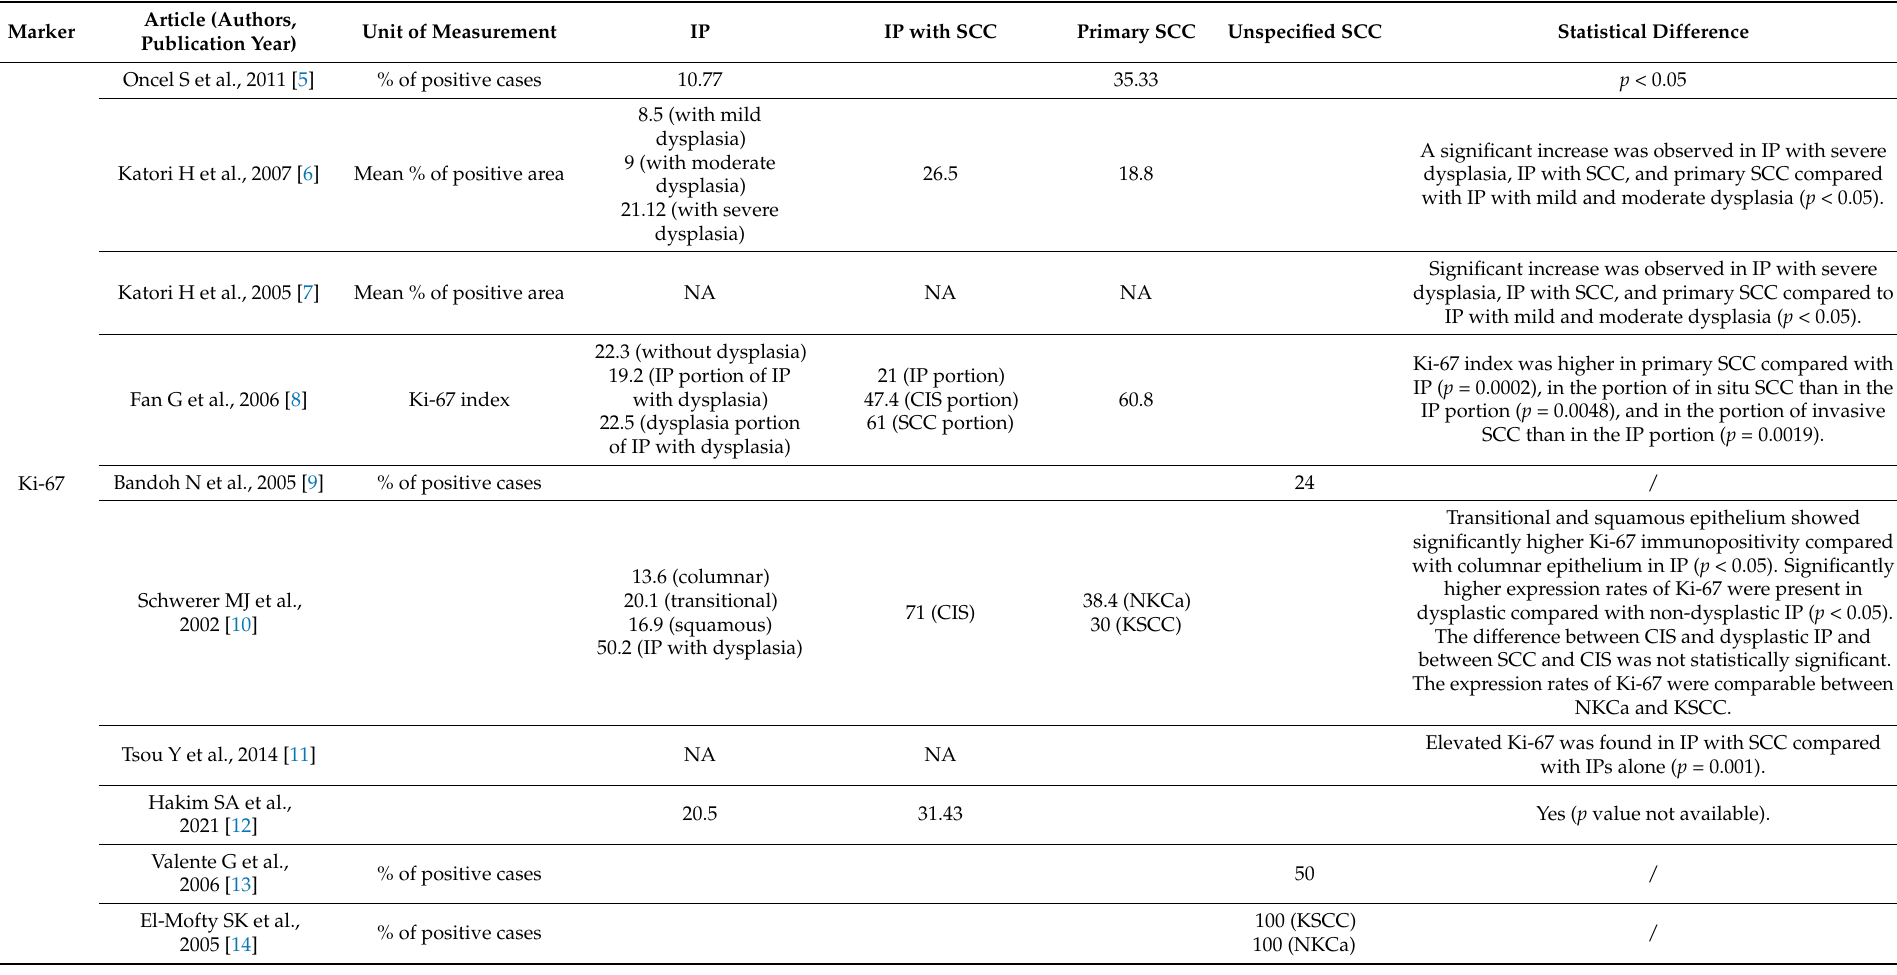
Table 1. Summary of immunohistochemical markers of inverted papilloma (IP) and SNSCC (Sinonasal Squamous Cell Carcinoma). CIS (Carcinoma in situ);